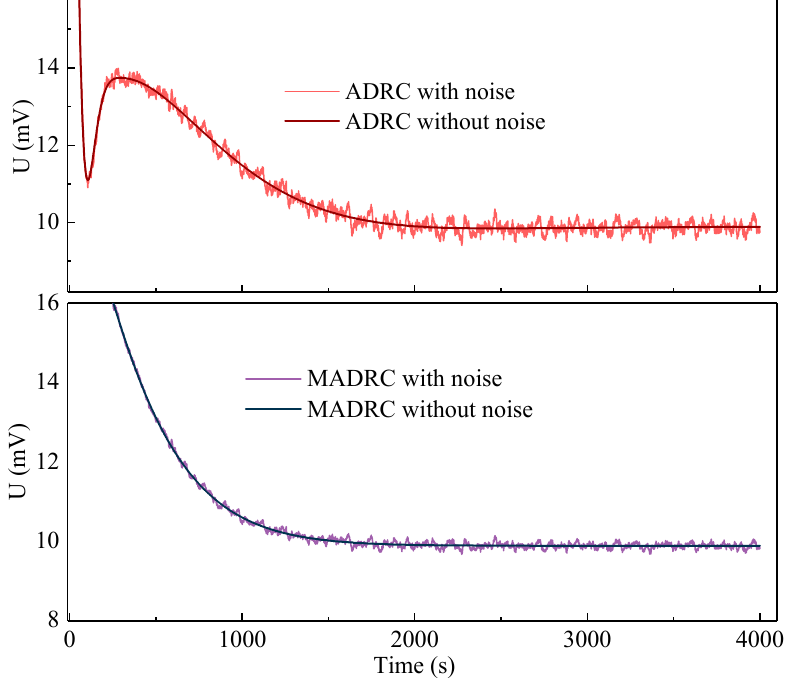
Figure 10. Simulation of noise reduction and the fluctuation of output values.